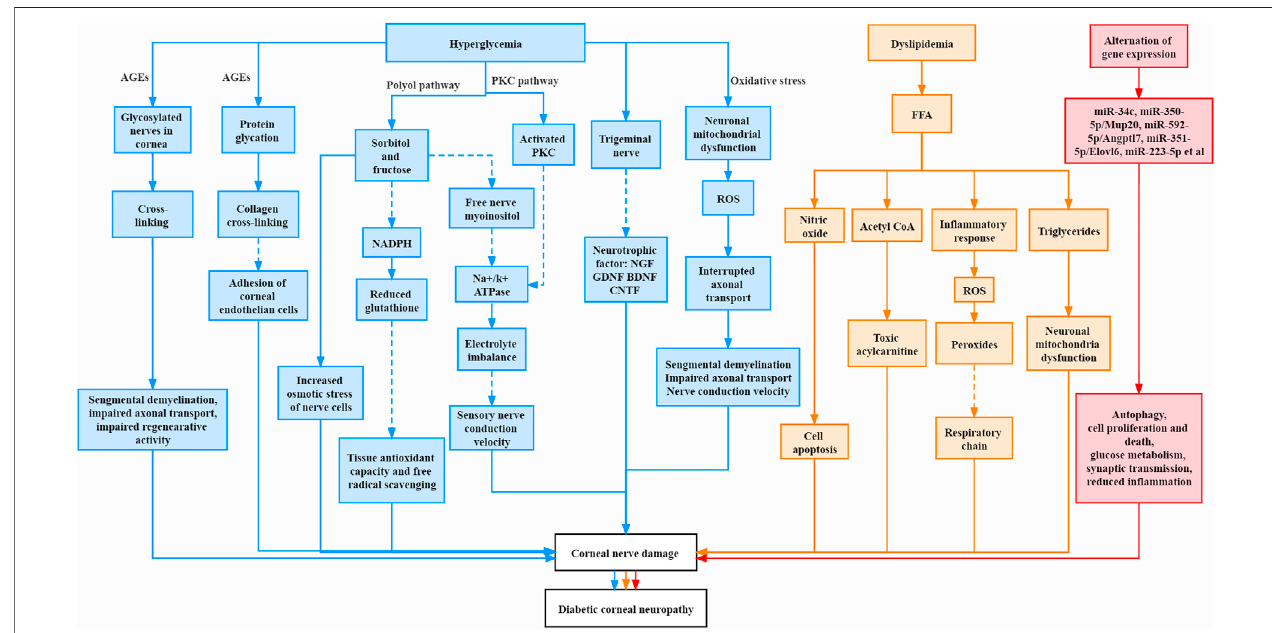
FIGURE 1 | Pathogenesis of corneal neuropathy in diabetes mellitus. The Solid line represents increase and promotion, and the dashed line represents decrease and inhibition.